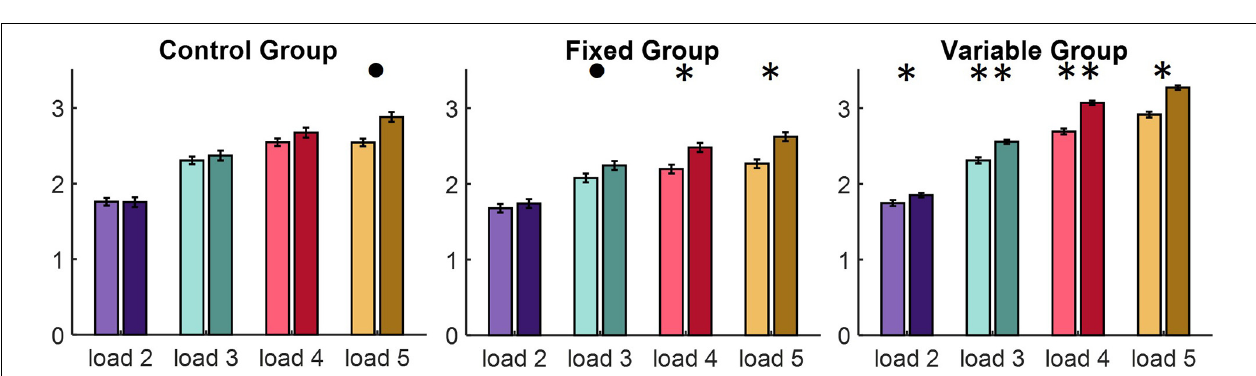
FIGURE 2 | Telemetric variables obtained from the StarCraft II (SC2) environment. While hours spent playing SC2 (upper left) allows us to confirm that both groups (VG: Variable Group; FG: Fixed Group) fulfill training assumptions, other variables indicate players’ proficiency. Barplots presenting first army unit creation (lower left) and first supply collection (lower right) give latencies in seconds. Asterisks indicate statistical significance: ∗ p < 0.05, ∗∗ p < 0.01.